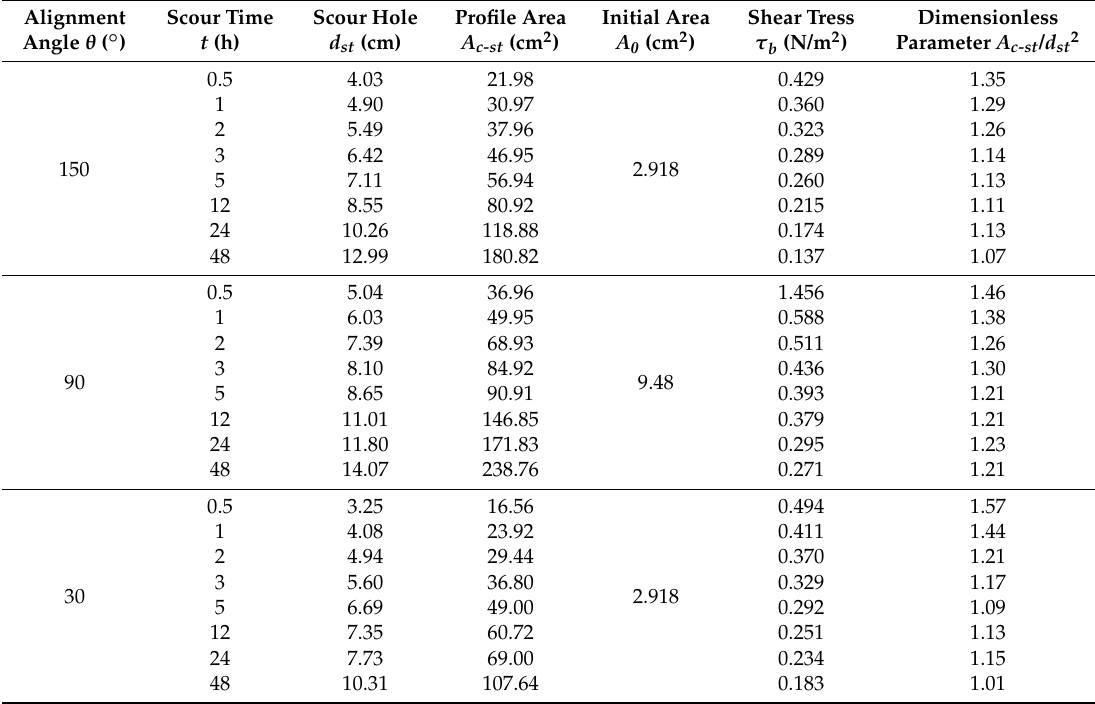
Table 2. Scour depth and the profile area of scour hole.